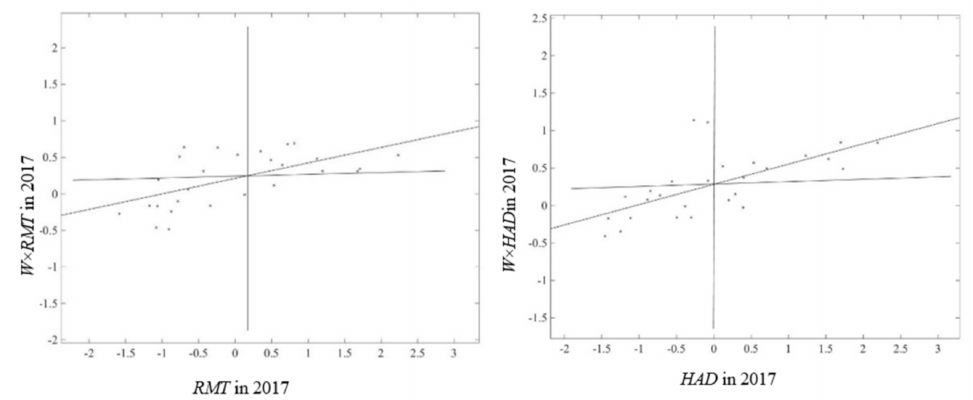
Figure 5. Moran’s scatterplots of RMT and HAD.